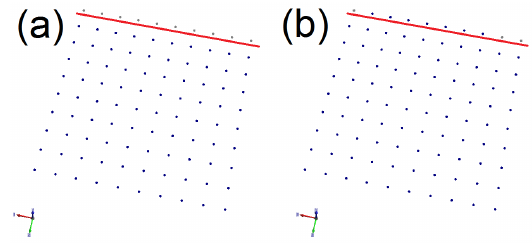
Figure 3: Subfigure (a) shows the AABB bounding box with the points inside. (b) Shows the quadtree centered in the same place of the AABB with points split in different cells.